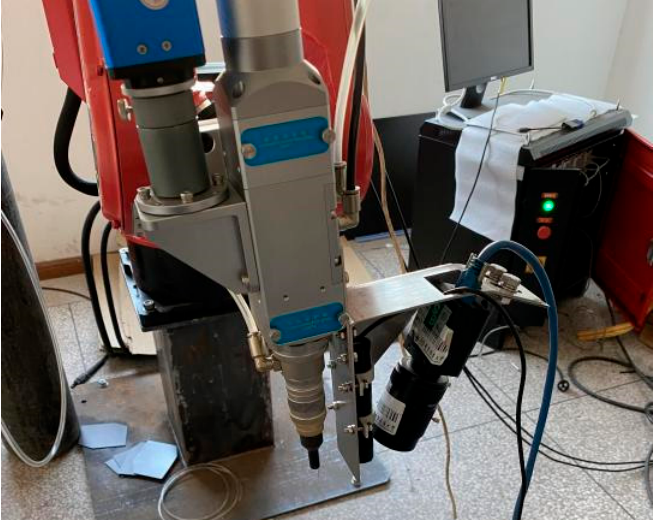
Figure 2. Weld tracking module. ( 1 ) Shell, ( 2 ) line laser transmitter, ( 3 ) industrial camera, ( 4 ) camera lens, and ( 5 ) optical filter.